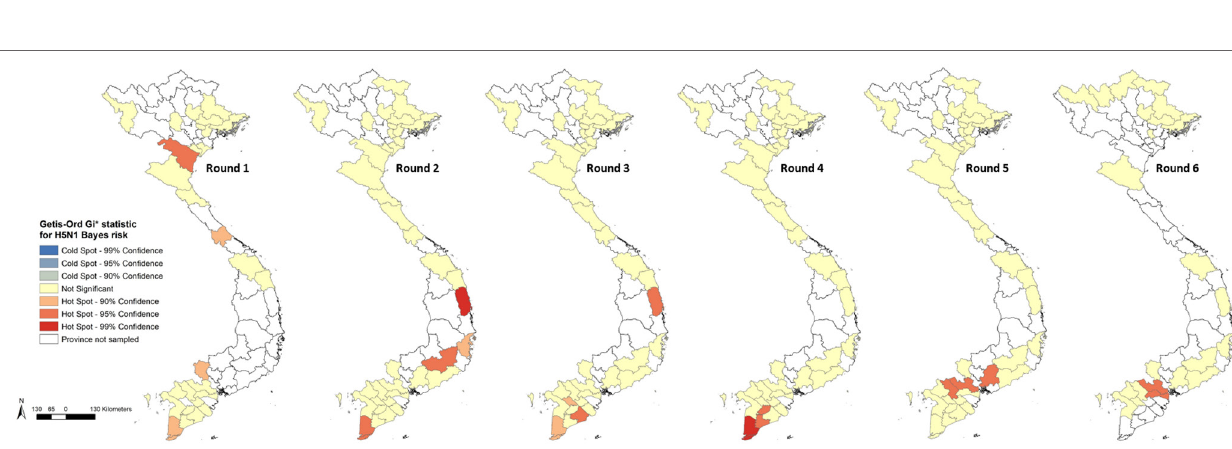
FigUre 2 | Local Indicators of Spatial Association cluster maps and Moran’s I statistics of highly pathogenic avian influenza H5N1 Bayes risk for Rounds